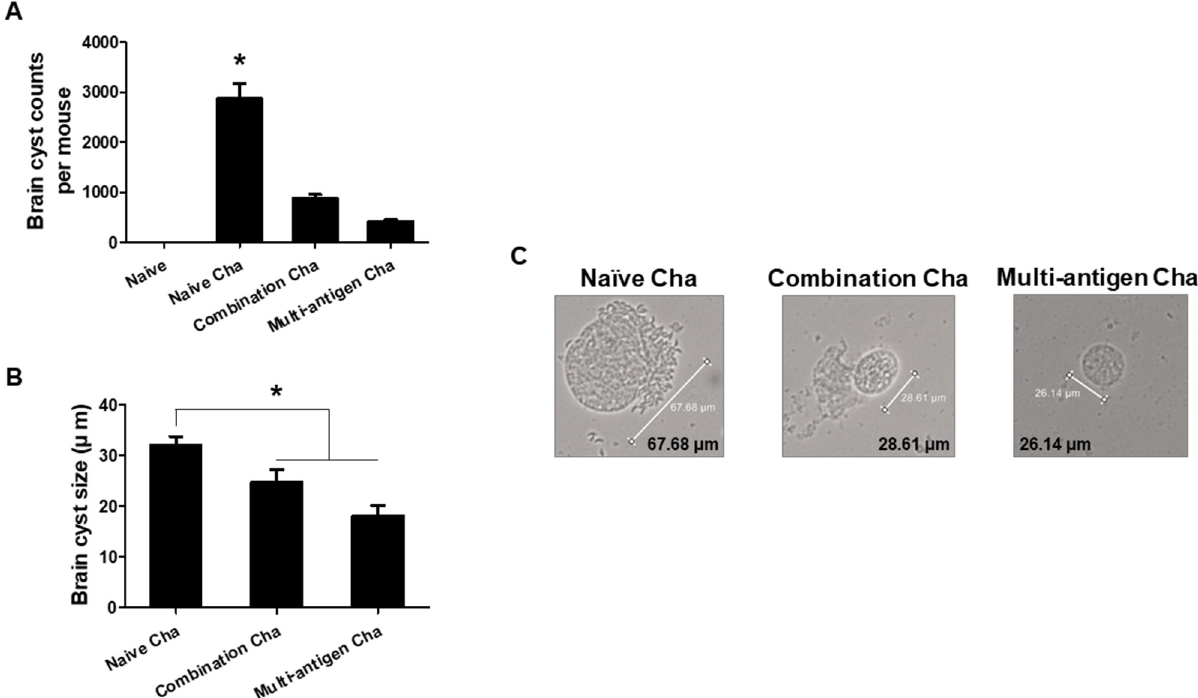
Fig 7. Parasite inhibition. To investigate the vaccine efficacy, mice brain was collected at week 4 after challenge infection. T . gondii (ME49) were separated individually from mice brain and counted under the microscope. The number of brain cysts was significantly reduced in multi-antigen or combination VLPs immunized mice compared to na ï ve mice upon challenge infection (A, � P < 0.01). The cysts size was significantly reduced in Multi-antigen Cha (18 μ m) or combination Cha (24.8 μ m) compared to Na ï ve Cha (32 μ m) (B and C, � P < 0.01).